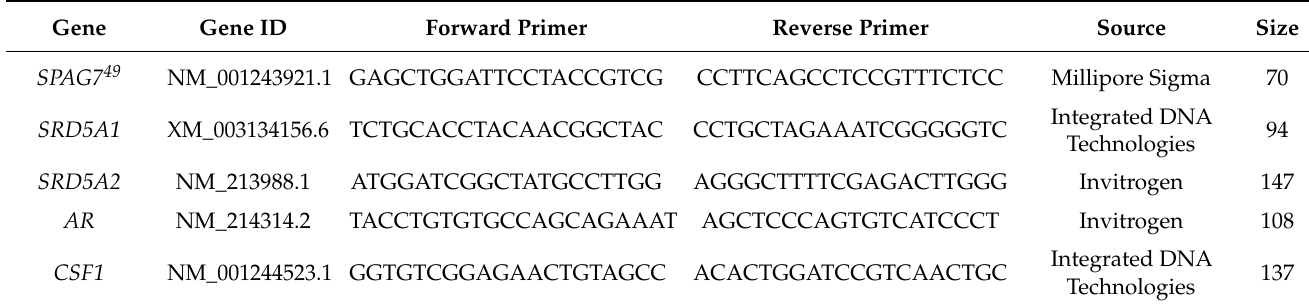
Table 2. Primers used in qPCR analysis of gene